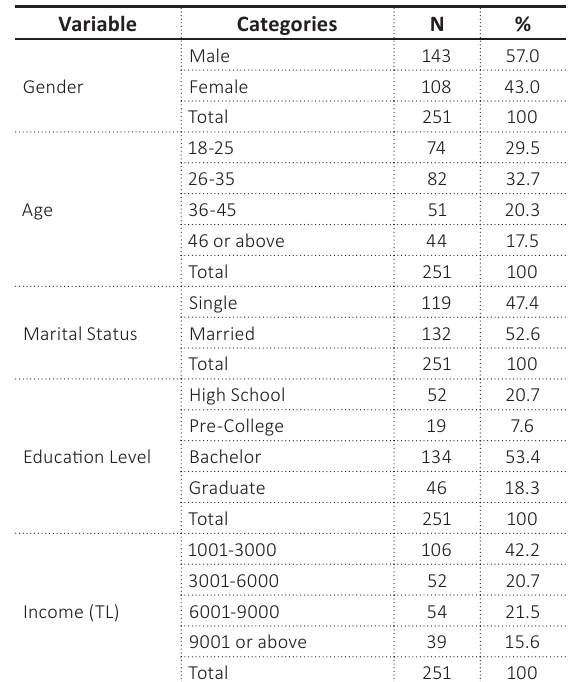
Table 1. Demographic profile of